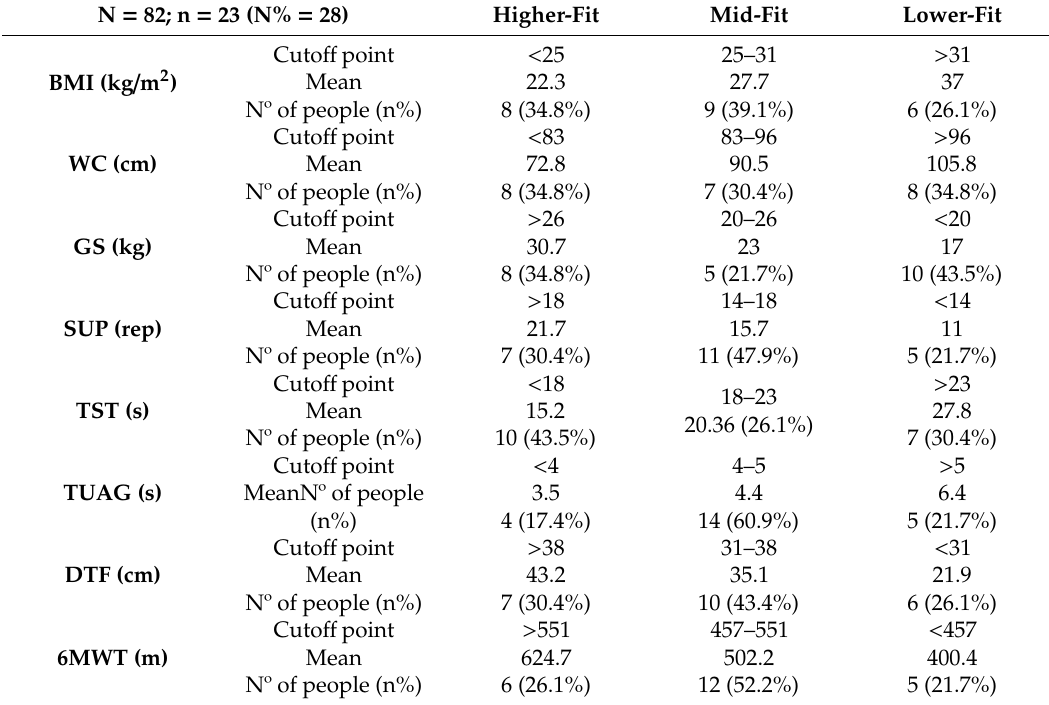
Table 4. Younger women ( < 30 years old) results for each variable categorized in 3 PF levels. N = 82; n = 23 (N% =